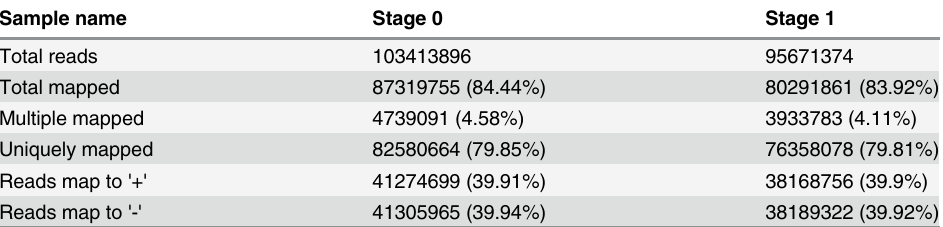
Table 1. Summary of clean reads mapping to the Ovis_aries_v3.1 reference genome